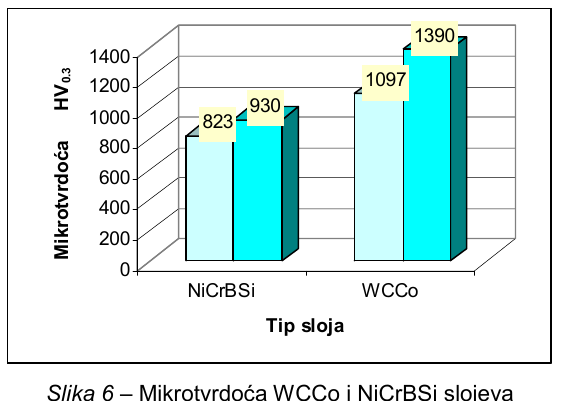
Figure 6 – Microhardness of WCCo and NiCrBSi